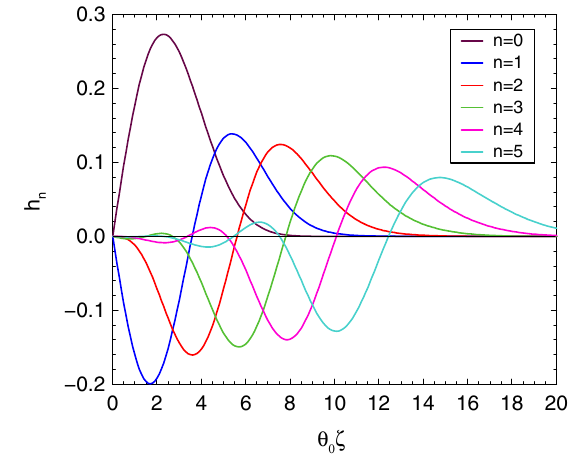
ð (cid:1) 0 (cid:5) Þ of the truncated Gaussian bunch. FIG. 12. Functions h n The curves represent the multibunch effect due to variation of the resistive wall wakefield inside a bunch. The right-hand parts of these odd functions are